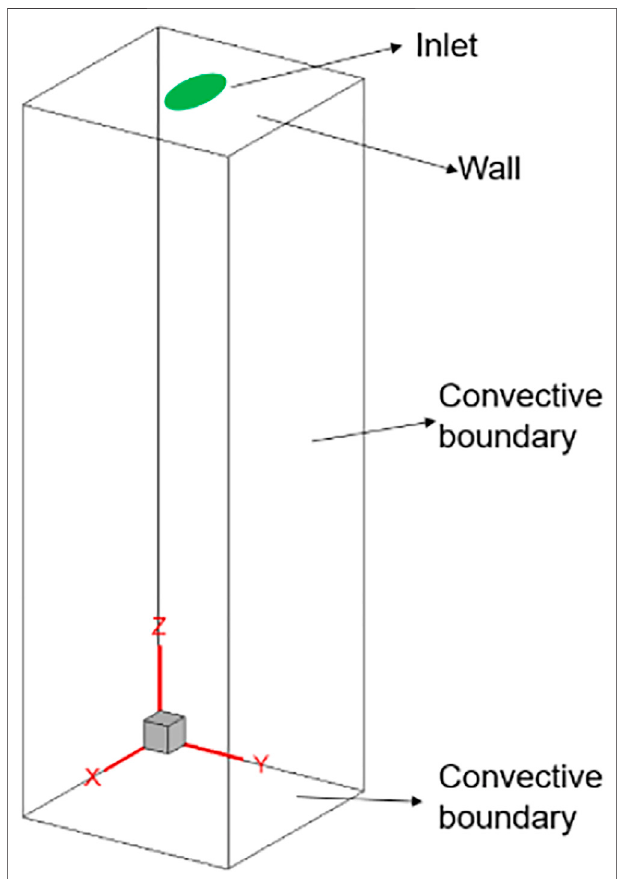
FIGURE 1 | Computational domain for the corium jet breakup